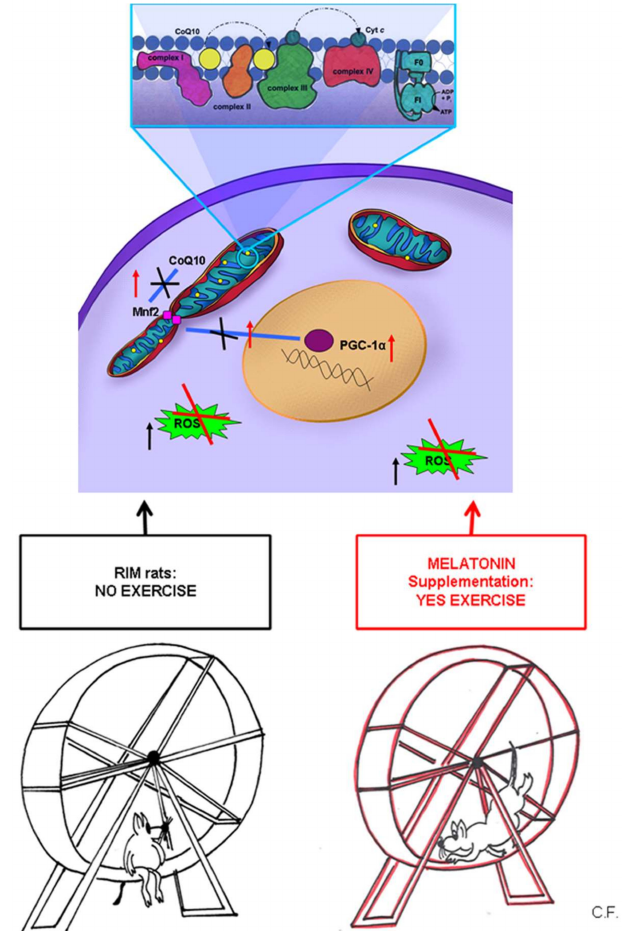
Figure 4. Mitochondrial involvement in fibromyalgia syndrome. A schematic diagram representing the important role of mitochondria in normal and in FMS underlining the biosynthetic pathway mediated by PGC-1 α . The decrease of PGC-1 α expression induces downregulation of Mfn2 that, in turn, determined a decrease of CoQ10 expression in the inner of mitochondrial membrane. In mitochondria CoQ10 is a part of electron transport chain among several complexes likely to cytochrome C on the complex IV. It is also depicted the potential beneficial effects of melatonin in RIM rats and so, its role in the maintenance of health. Mfn2 = mitofusin2; PGC-1 α = peroxisome proliferator-activated receptor gamma coactivator 1-alpha; ROS = reactive oxygen species; CoQ10 = coenzyme Q10; Cyt c = cytochrome complex; RIM rats = reserpine-induced myalgic rats; F0 = “Fraction 0” of the ATPase; it is a proton pore that is embedded in the mitochondrial membrane; F1 = “Fraction 1” of the ATPase; it is the portion responsible for hydrolyzing ATP; ADP = adenosine diphosphate; Pi= inorganic phosphate; ATP = adenosine